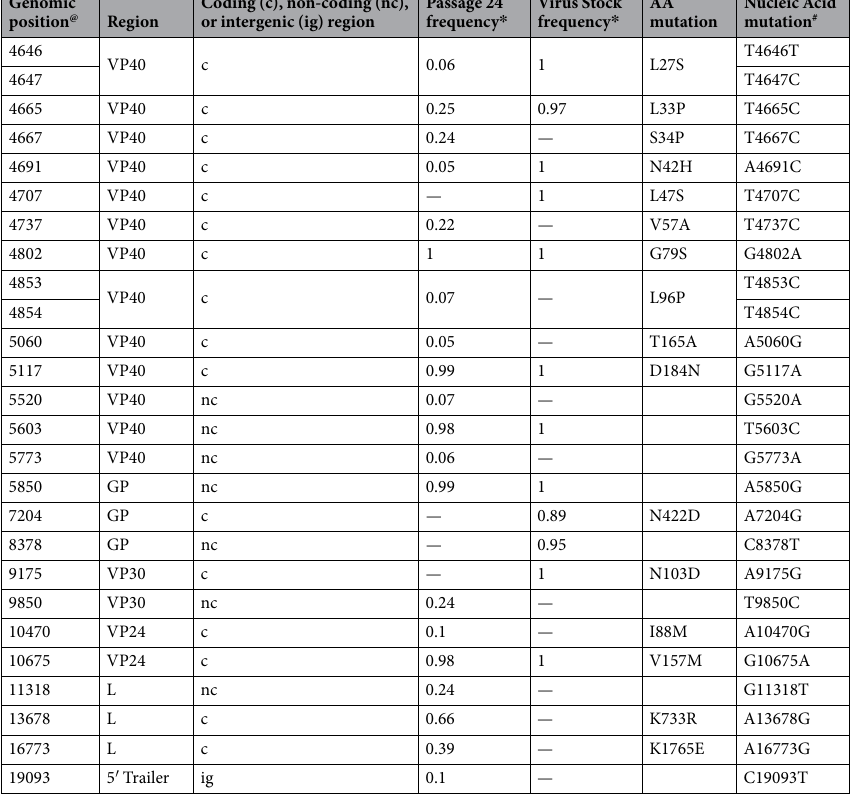
Table 1. Comparison of mutations present in passage 24 and in the virus stock. @ Multiple sites in the same cell were found to always move together. * “—” represents mutations that were not detected. # Based on positive- sense